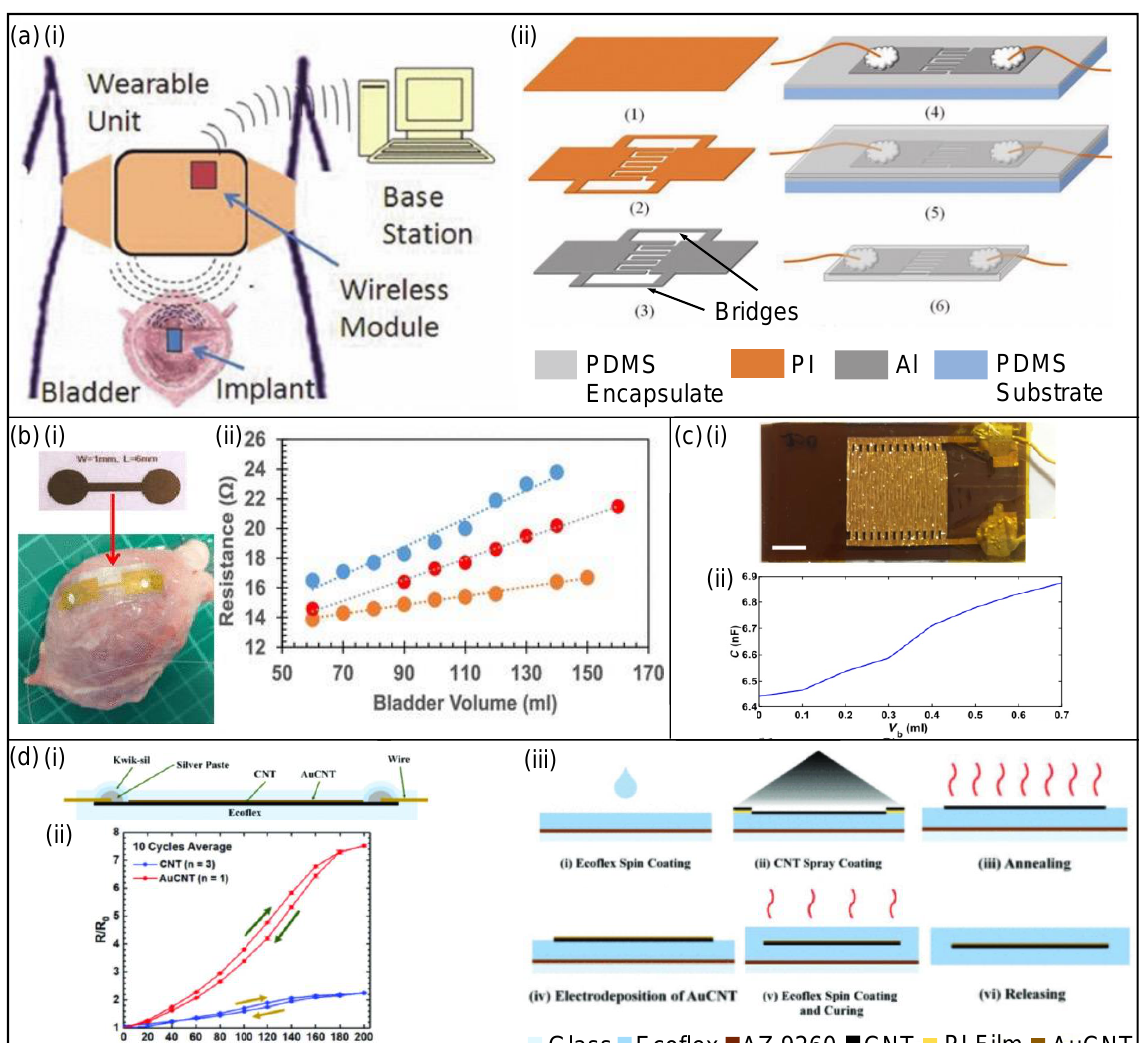
Figure 8. Bladder-monitoring devices. ( a , i ) The conceptual design of the system consisting of the capacitance-based sensor implant, an external wearable unit, and a receiver base station for data acquisition, and ( ii ) the fabrication process of the sensor [60]. Copyright 2013, IEEE. ( b , i ) The capacitance- based sensor, showing the top view of the wrinkled electrodes, and ( ii ) a capacitance–volume curve for bladder filling [48]. ( c , i ) The laser-patterned stretchable strain sensor, and ( ii ) the capacitance versus bladder volume for various sensor placements on the bladder [63]. ( d , i ) Cross-sectional image of the AuCNT strain sensor, ( ii ) comparative results of the CNT strain sensor versus the AuCNT strain sensor, and ( iii ) fabrication process of the strain sensor [64]. Copyright 2021, IEEE. Strain Sensors Hannah et al. [63] produced a soft, biocompatible sensor using stretchable electronics Another strain sensor developed by Jo et al. [64] uses Ecoflex-carbon-nanotube (CNT) and formed gold-CNT (AuCNT) fused on a CNT film to monitor bladder volume.